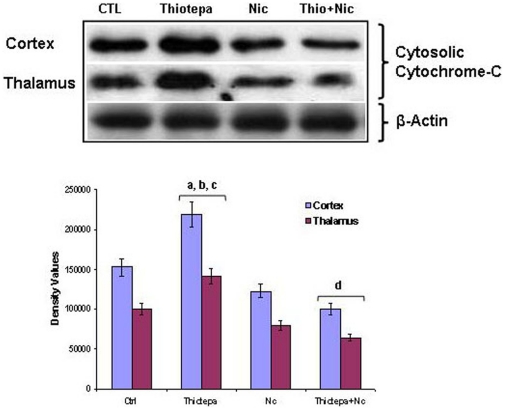
Co-treatment effect of nicotinamide on thiotepa-induced cytosolic cytochrome c levels.Representative Western blot analysis of cytochrome c levels in the cortex and thalamus of 7-day-old rats. Significant increases in the cytosolic level of cytochrome c in the cortex and thalamus after administration of thiotepa are shown. Treatment with nicotinamide for 4 h significantly reduced thiotepa-induced cytosolic cytochrome c levels in cortex and thalamus, as shown. The protein bands of the Western blot were quantified using Sigma gel software analysis; their differences are represented in the graph. Actin reactivity was used as a protein loading control. Density values, expressed as mean ± SEM (n = 5–6 animals/group), for cytochrome c and activated caspase-9 are presented. The density values on the Y-axis are expressed as arbitrary units (AU). Statistical difference was determined using one-way analysis of variance (ANOVA) followed by Student's t-test. (aSignificantly different from CTL, [cortex P<0.05 and thalamus P<0.05]); bSignificantly different from Nicotinamide, [cortex P<0.05 and thalamus P<0.05]; cSignificantly different from Thiotepa + Nicotinamide, [cortex P<0.01 and thalamus P<0.01]; dSignificantly different from Thiotepa, [cortex P<0.01 and thalamus P<0.01]).